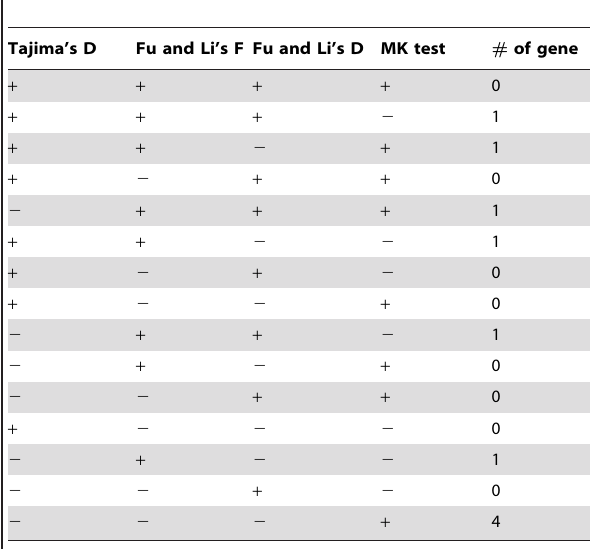
Table 2. The average values of p and h for all the sites, synonymous and non-synonymous sites of NDGs and parental genes.